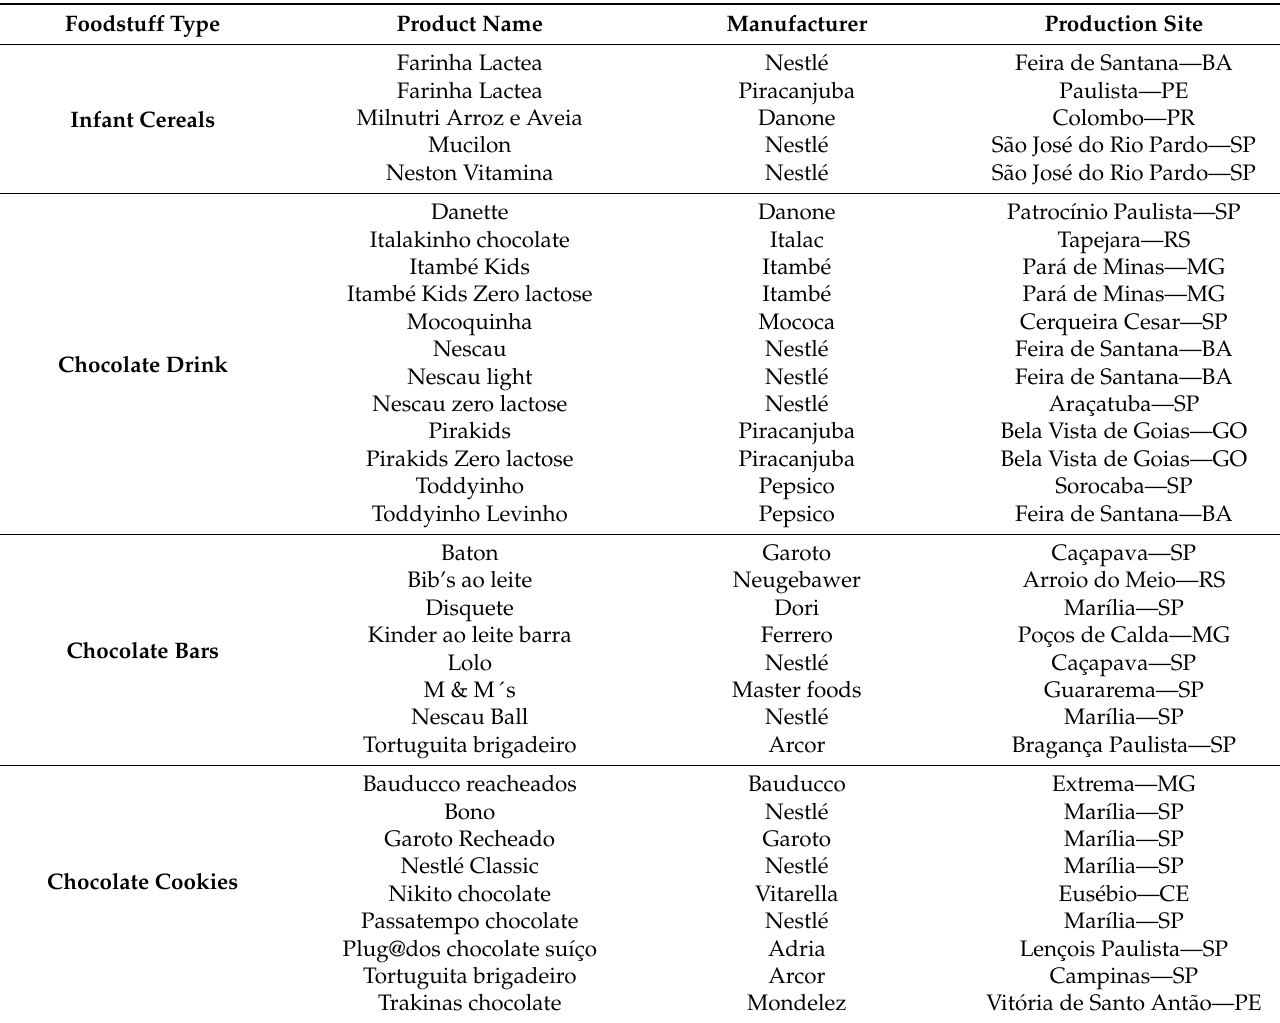
Table 1. Name, manufacturer, and production site of the infant cereals, chocolate drinks, chocolate bars, and chocolate cookies that were